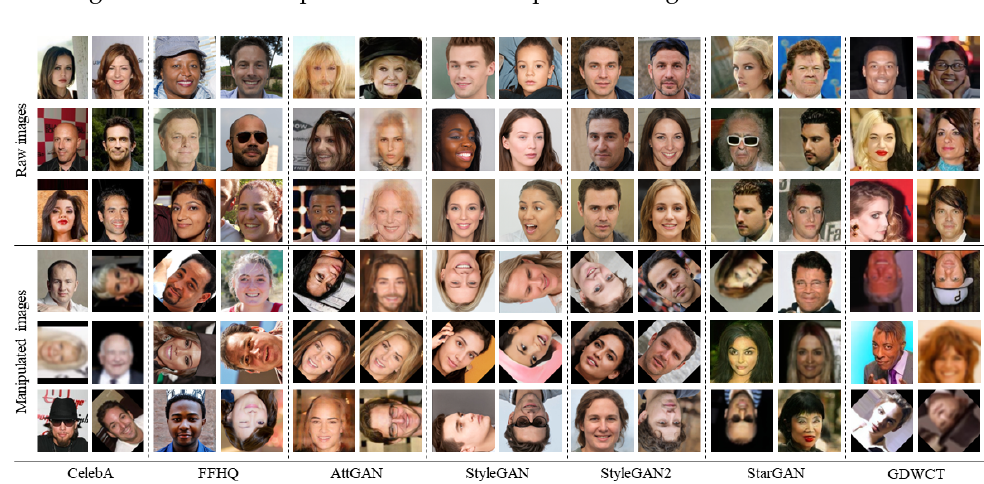
Figure 3. Examples of real (CelebA and FFHQ) and Deepfake images created by different GAN engines (AttGAN, StyleGAN, StyleGAN2, StarGAN, and GDWCT). The columns denote the source of the images. The rows ( Raw images and Manipulated images ) show examples of images without and with attacks.